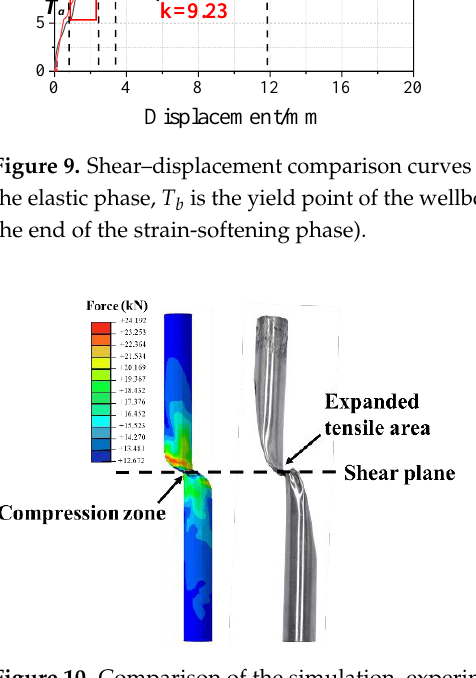
Figure 10. Comparison of the simulation–experiment results.